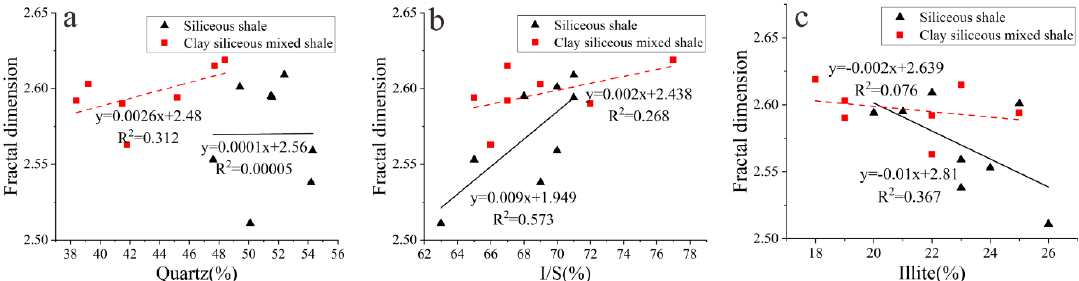
Figure 15. Relationships between mineral compositions and fractal dimension among different shale lithofacies. ( a ) relationships between quartz and fractal dimension among different sgale lithofacies; ( b ) relationships between I/S and fractal dimension among different sgale lithofacies; ( c ) relationships between illite and fractal dimension among different sgale lithofacies.